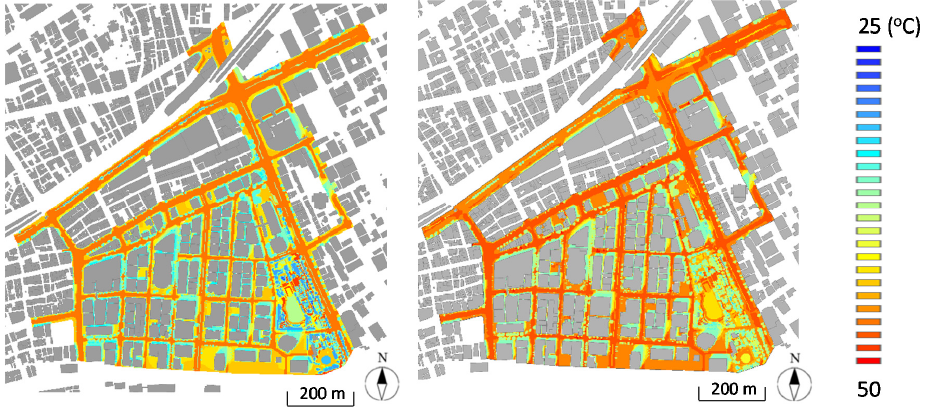
Figure 8. Distribution of ground surface temperature (left) and mean radiant temperature (MRT) (right) at 1.5 m height at 1:00 p.m. on 5 August 2019. Atmosphere 2020 , 11 , x FOR PEER REVIEW